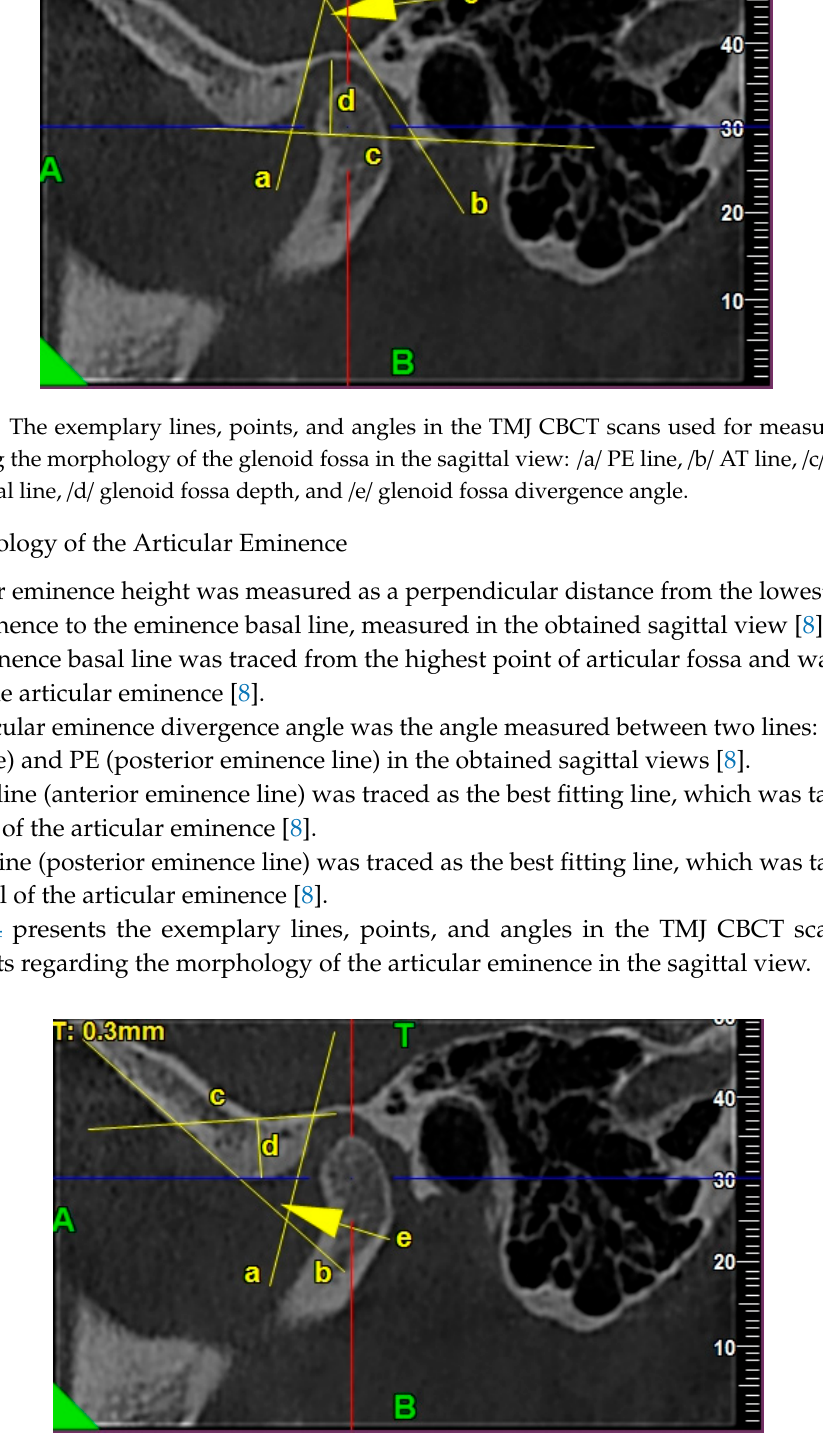
Figure 4. The exemplary lines, points, and angles in the TMJ CBCT scans used for measurements